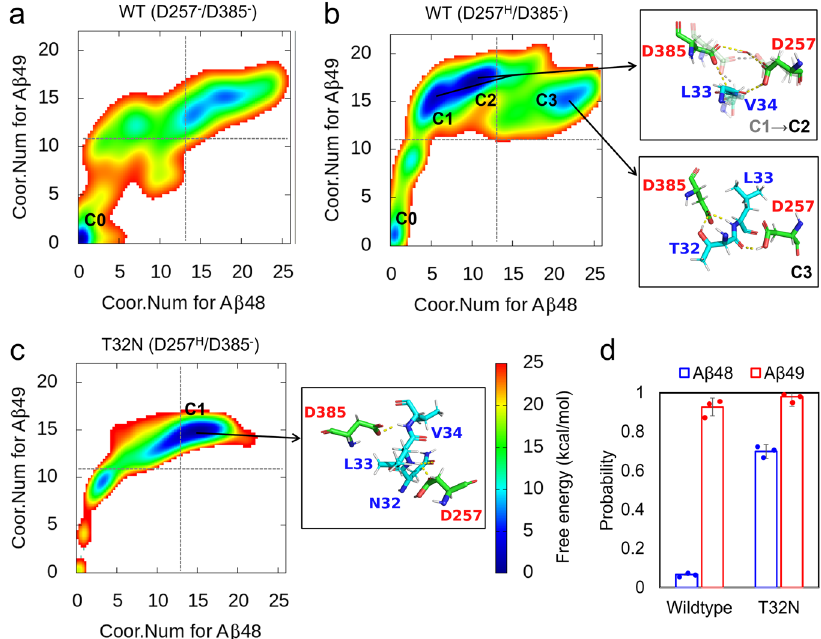
Fig. 6 Structural con fi gurations formed in the wild-type system prefers A β 49 cleavage while the T32N mutation on APP alters the A β 48/A β 49 cleavage ratio. a – c 2D free energy pro fi les of coordination formation for A β 48 and A β 49 cleavage from BE-MetaD simulations, as well as representative conformations corresponding to free energy minimums. a Inactive wild-type protein without protonation (D257 – /D385 – ), ( b ) active wild-type protein with protonated D257 and unprotonated D385 (D257 H /D385 – ), ( c ) active T32N mutant with D257 H /D385 – . (d) The occupancy of the hydrogen bonds between scissile bonds T32-L33 or L33-V34 and D257/D385 from the unbiased MD simulation for the wild-type and T32N mutant APP systems. Data are presented as mean values + / − standard